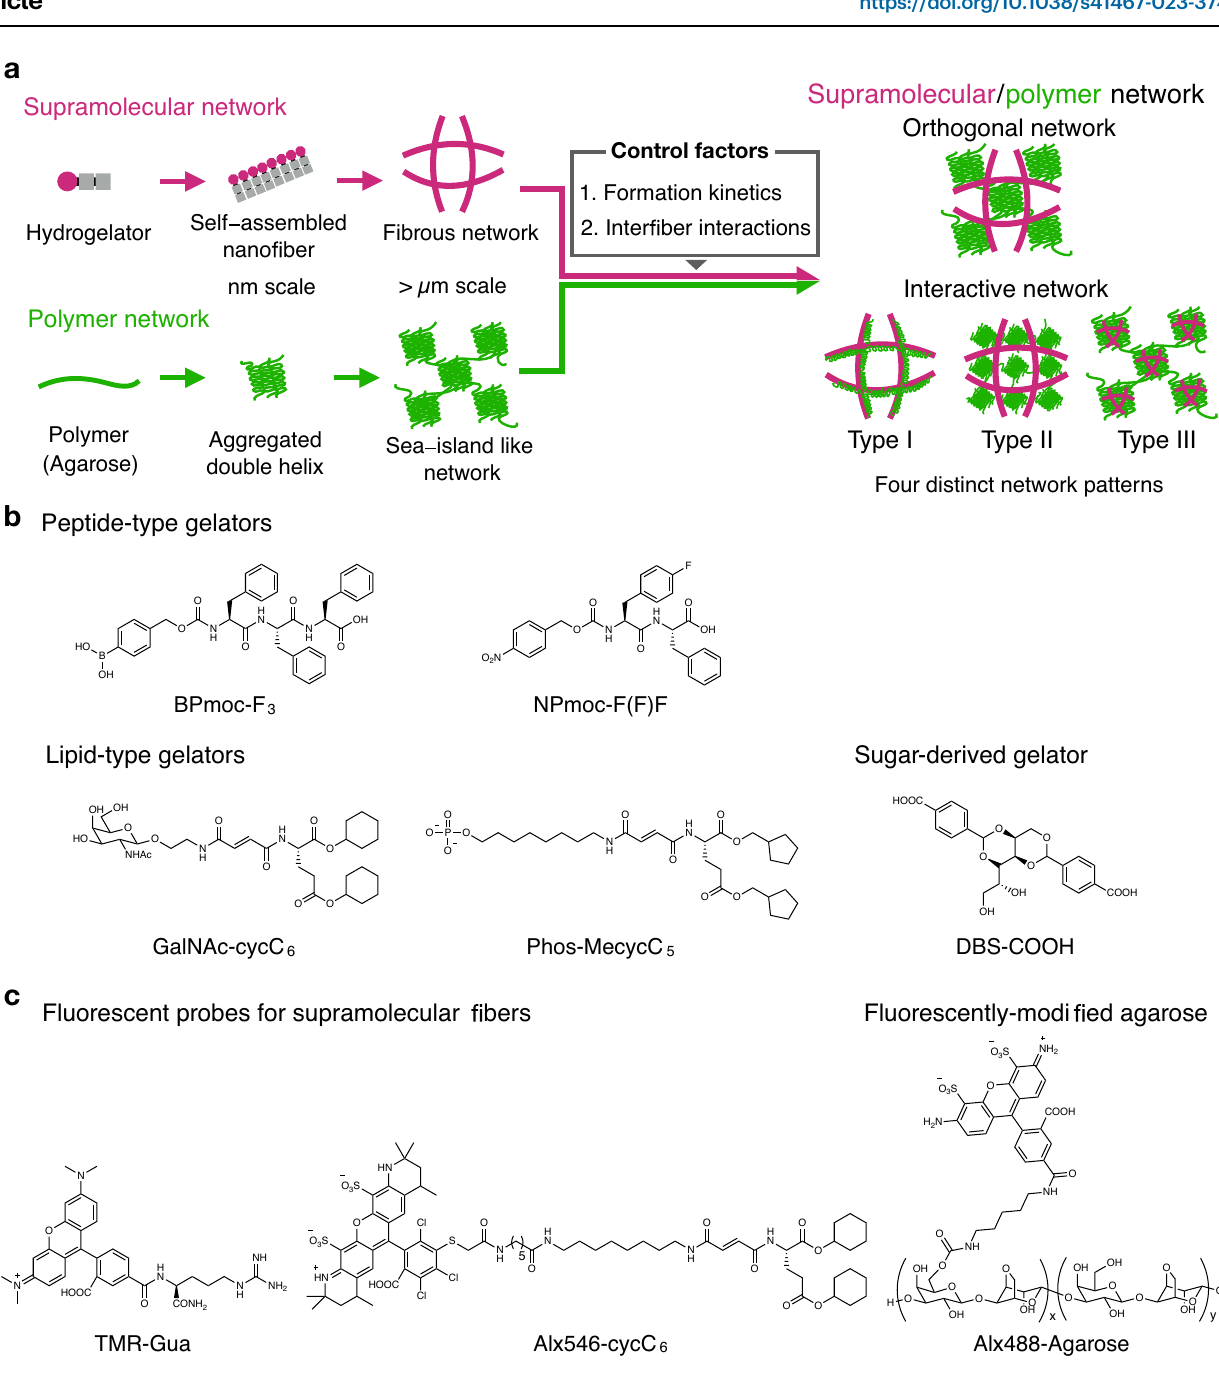
sugar-derived hydrogelators. Chemical structures of other hydrogelators are shown in Supplementary Fig. 1. c Chemical structures of fl uorescent probes